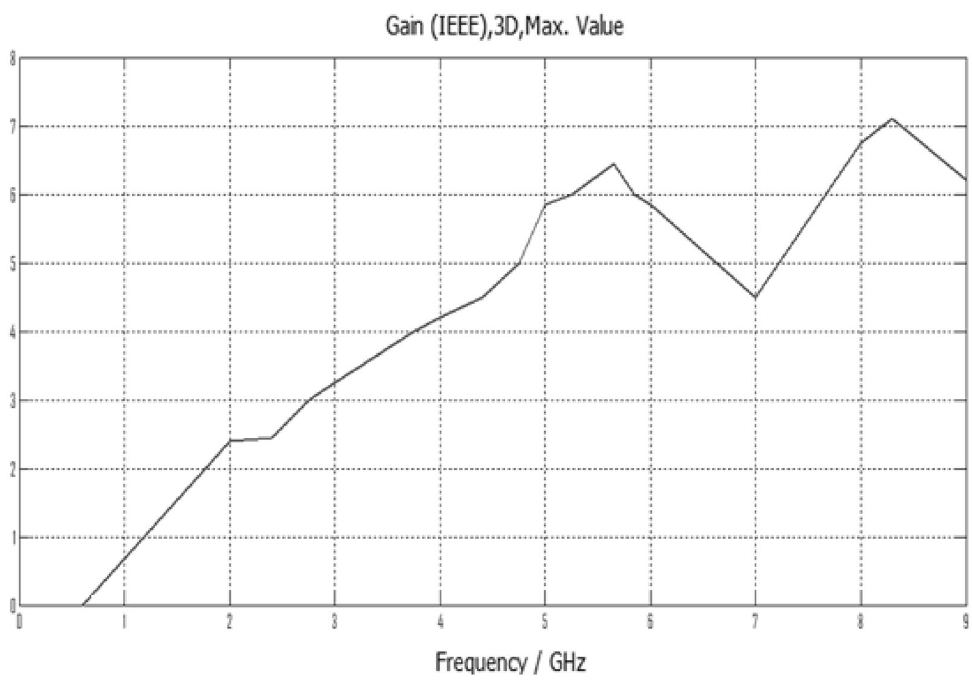
Figure 9. Gain result for